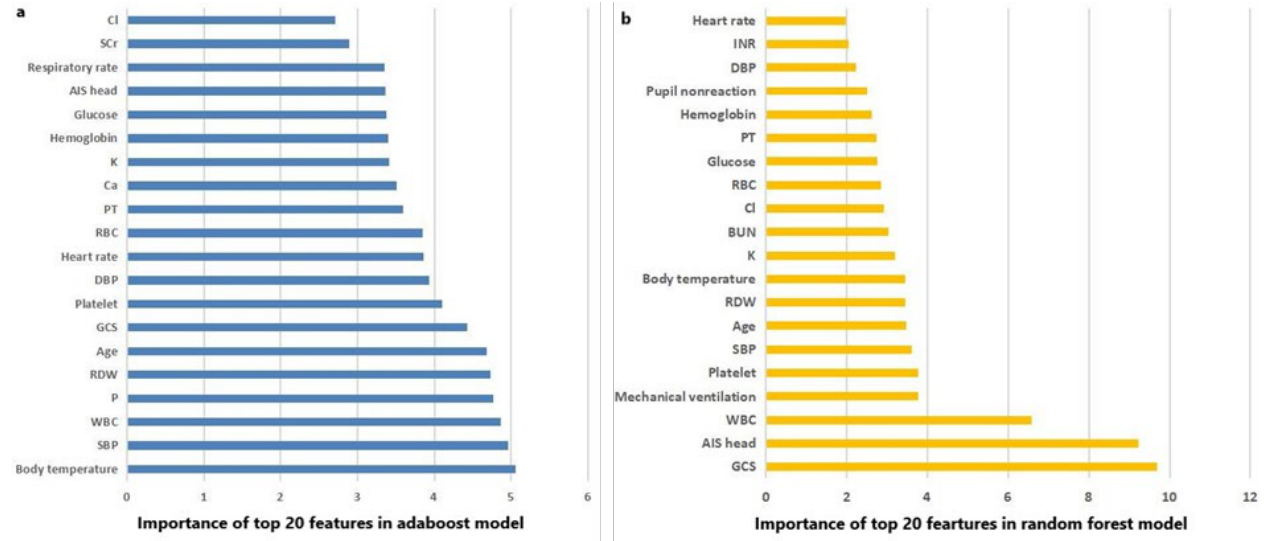
Figure 2. ( a ) The receiver operating characteristic curve of machine learning algorithms for predict- ing mortality in training set; and ( b ) receiver operating characteristic curve of machine learning algorithms for predicting mortality in testing set.